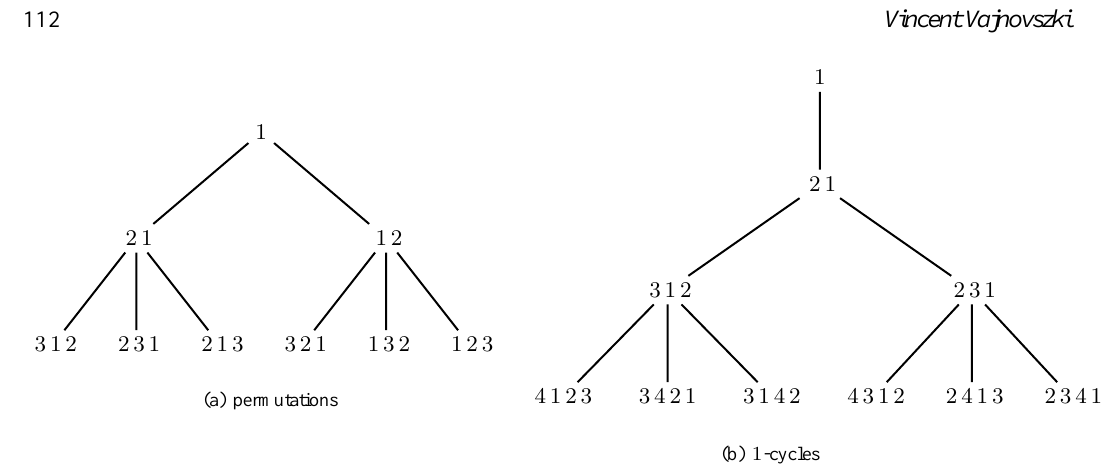
Fig. 1: The first levels of the generating tree for permutations and 1